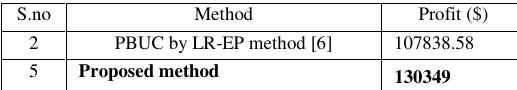
Comparison of the results of 10unit system (24Hr) with existing methods by proposed method